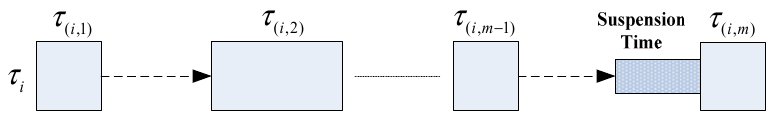
Figure 1. Structure of a HRCT τ